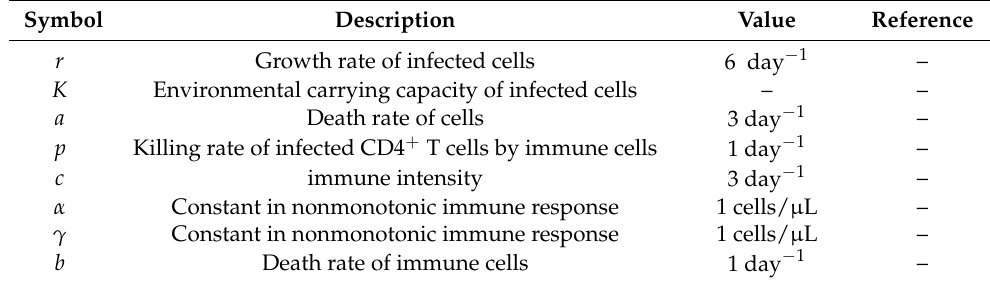
Table 4. Description and values of the parameters in model (2).